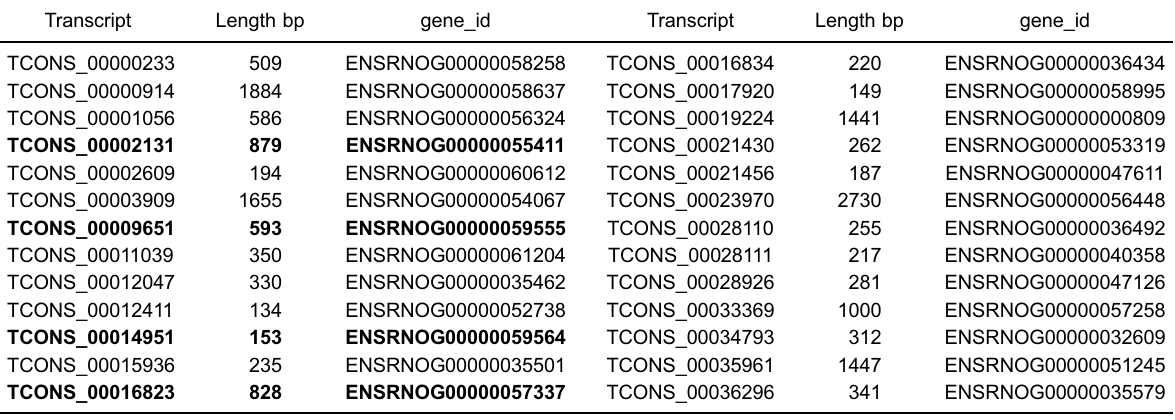
Table 7. Transcripts of 26 novel long non-coding RNA genes, of which 4 (in bold) are involved in co-expression network with target mRNA genes.